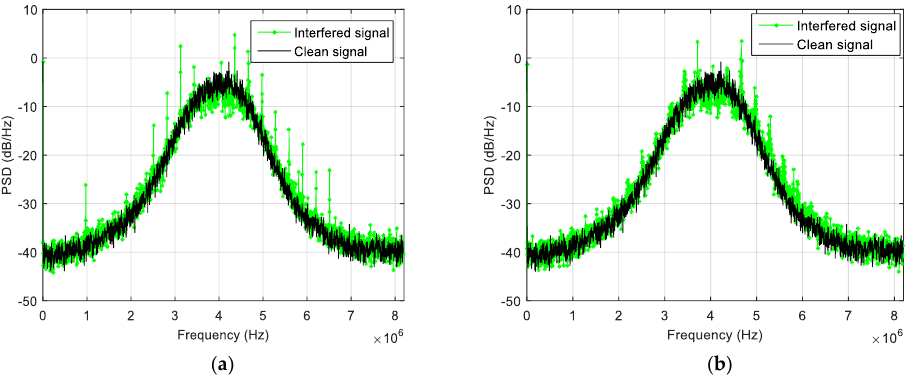
Figure 10. Case-study C. PSD anomaly detected on 7 March 2017 at 12 h:29 m:04 s ( a ) 15 h:30 m:51 s ( b ) local time, in Via Paolo Borsellino, Turin. ( b ) local time, in Via Paolo Borsellino,